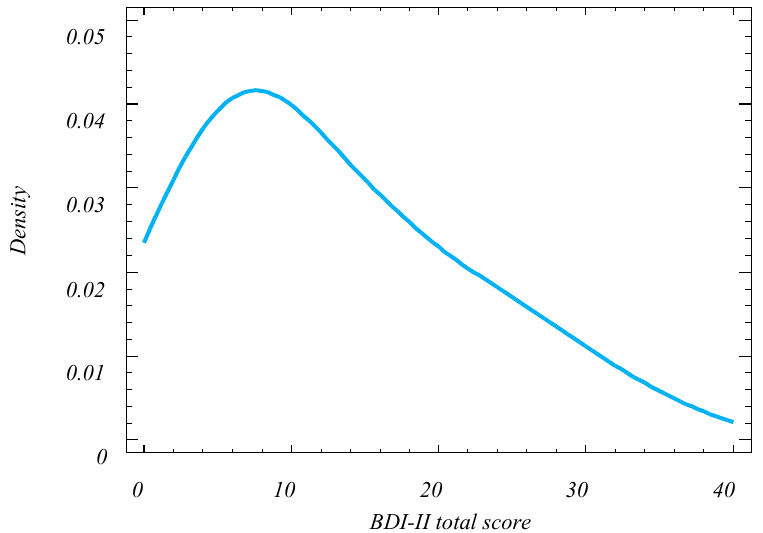
Figure 1. Smoothed density plot of BDI-II scores.